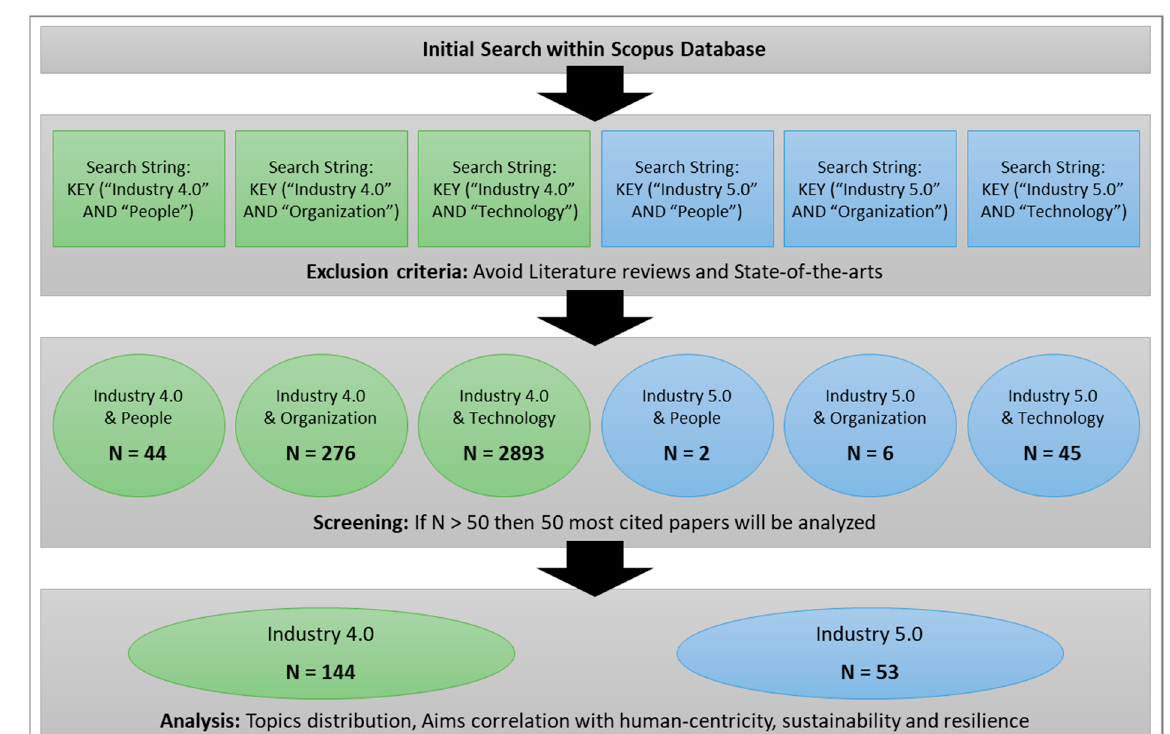
Figure 3. Flow of the scientific papers collection using the Scopus database.